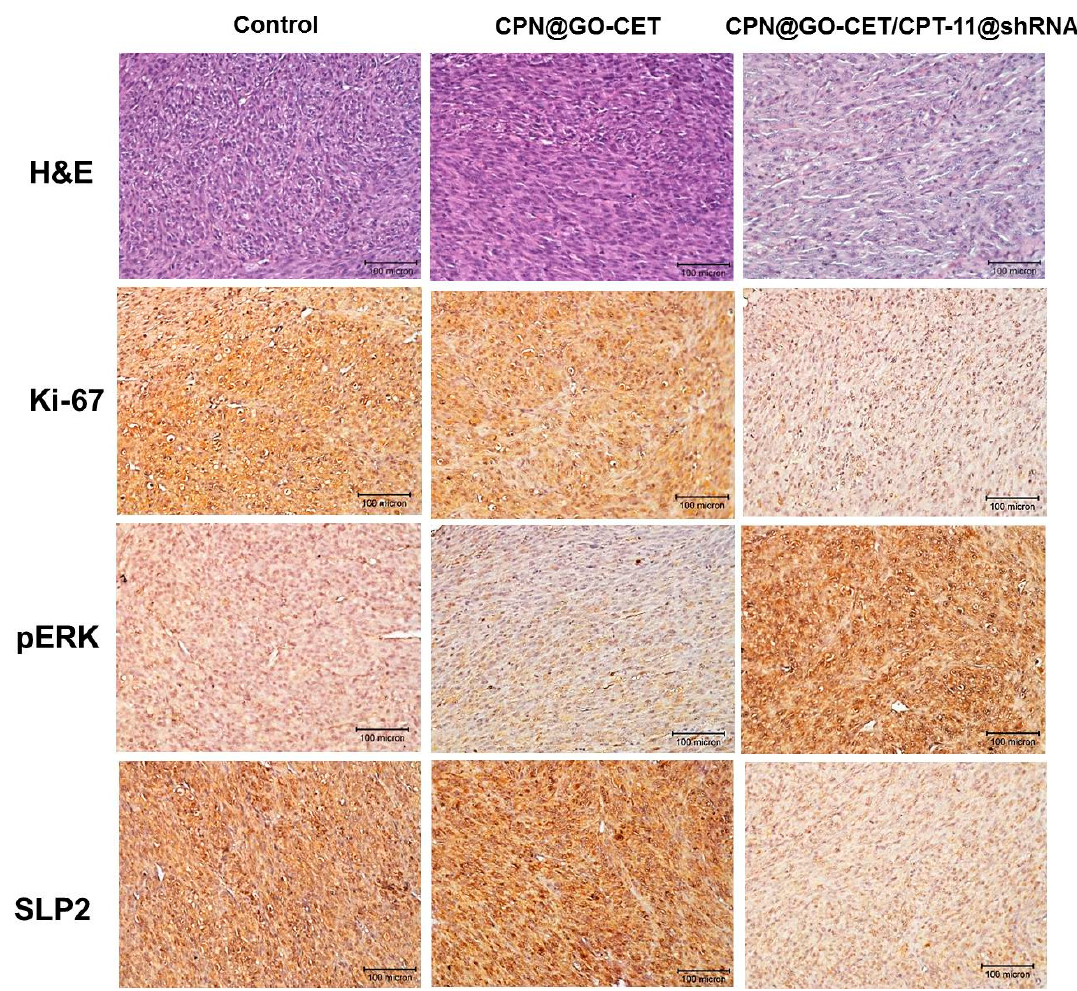
Figure 12. The H&E stain and immunohistochemistry (IHC) analysis of Ki-67, phosphorylated extracellular signal-regulated kinases (pERK), and SLP2 of U87 tumors in control group and groups treated with CPN-GO-CET or CPN@GO-CET/CPT11@SLP2shRNA (bar = 100 μ m).